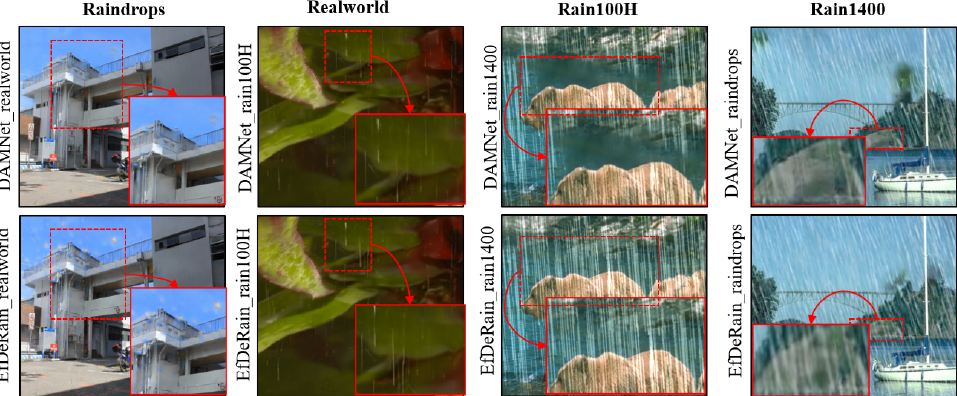
Figure 10. The comparison of DAMNet and EfDeRain [23] in the crossing-rain datasets, in which the training settings of DAMNet and EfDeRain are the same while the training and testing images are derived from different datasets. The models’ suffixes in Figure 10 are datasets for training themselves. The bigger images are the visual demonstration of rain removal, the zoomed image croppings furtherly highlight the final effect. The first row is the result of EfDeRain and the other is the display of DAMNet. Although the derained images have visible rain streaks, the more obvious tendency to remove rain tracks is clearly